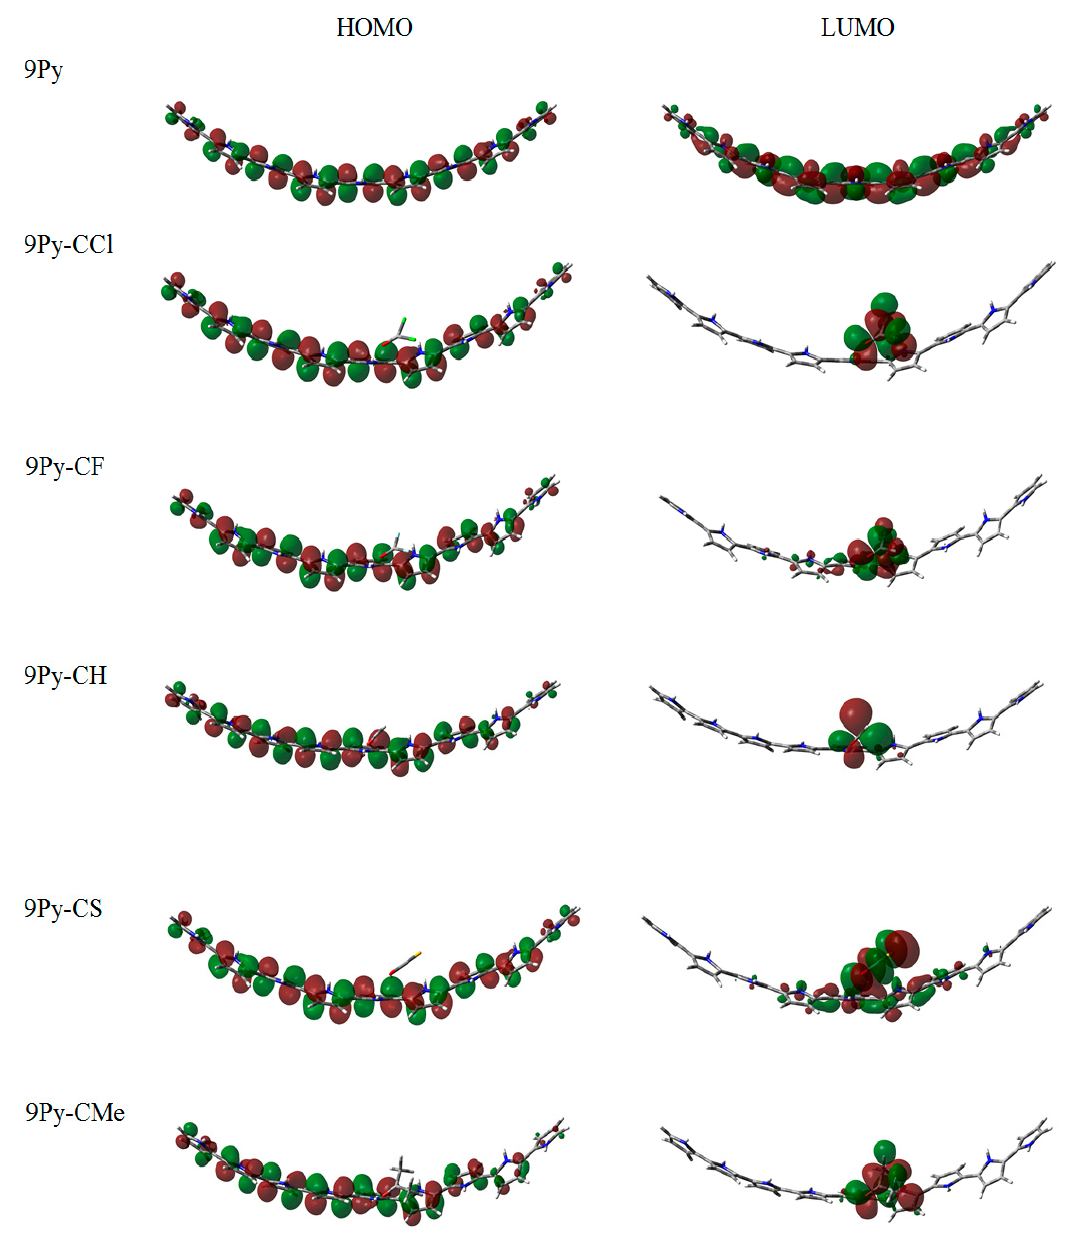
Figure 5. Frontier molecular orbital surface for the 9Py-HC complexes (isovalue = 0.02 a.u.).